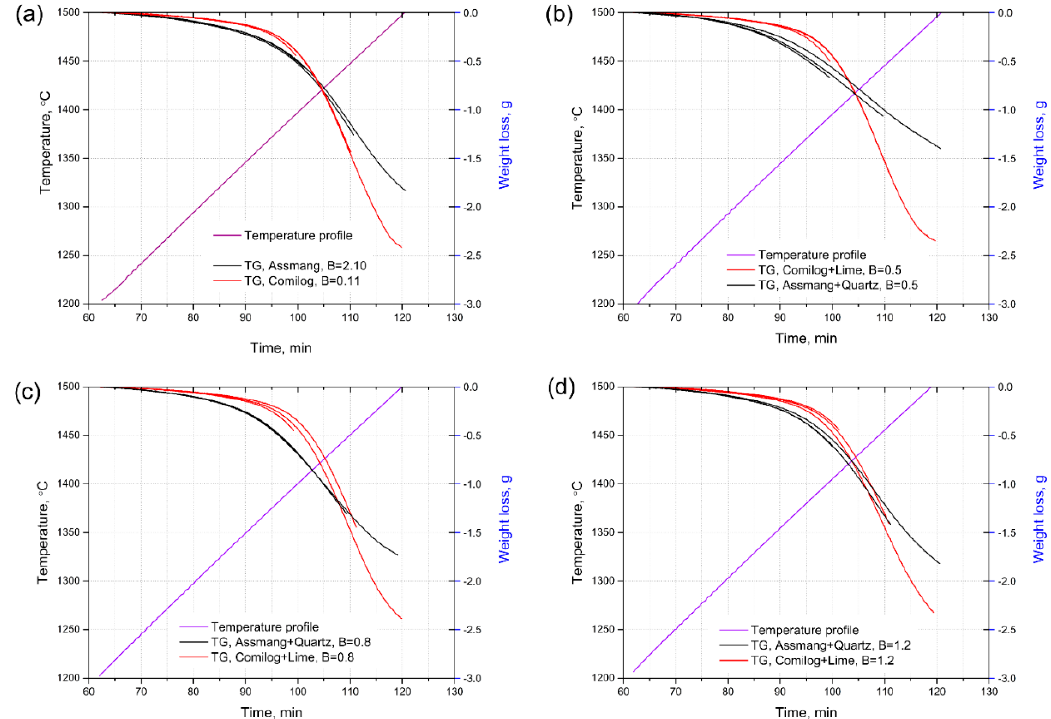
Figure 2. Reduction curves of charges with different basicities at MnO reduction stage, weight loss before 1200 °C is deducted. ( a ) Assmang with B = 2.10, Comilog with B = 0.11; ( b ) B = 0.5; ( c ) B = 0.8; ( d ) B = 1.2. Temperature profile is shown.